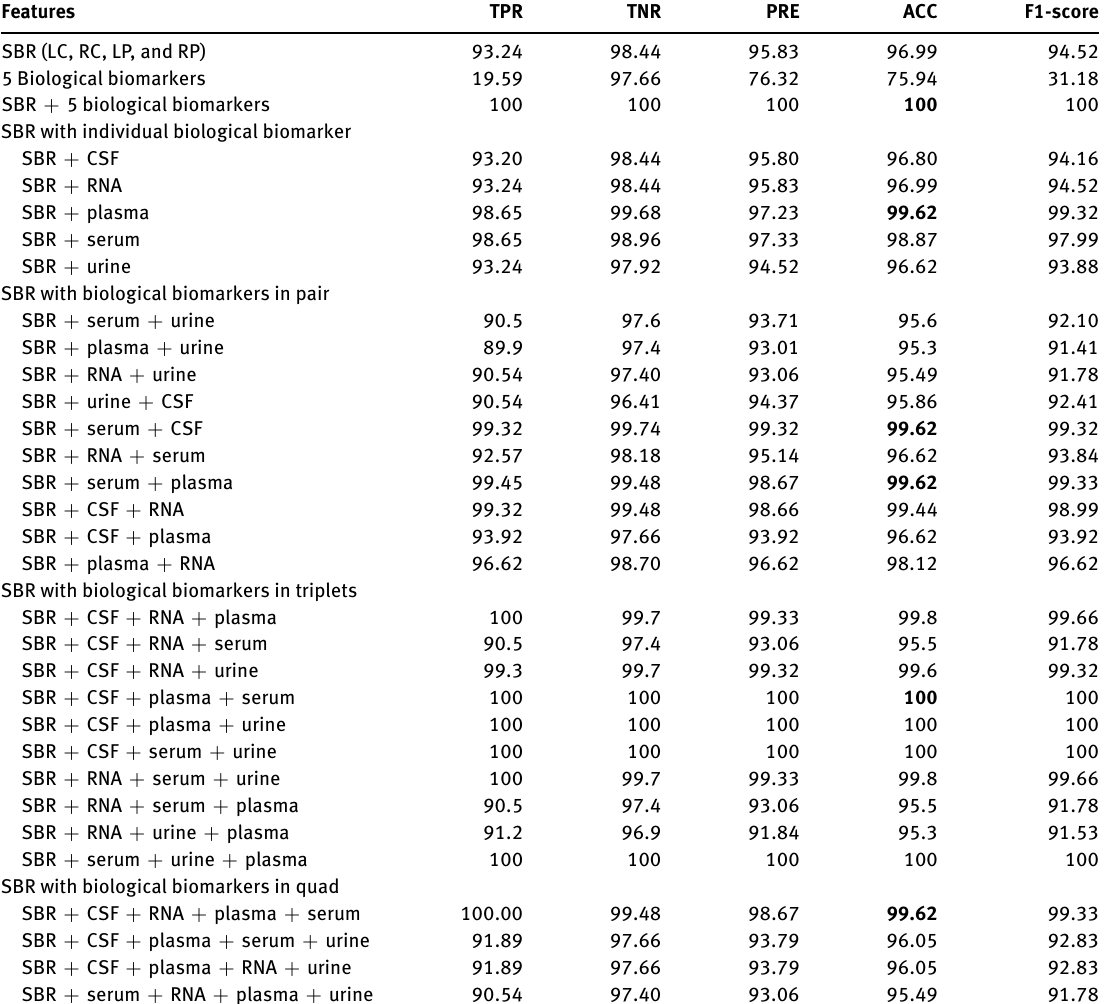
Table 2: Performance Parameters of Classification Model Using Softmax